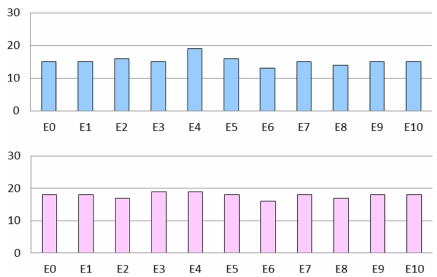
Figure 3. NRMSE of precipitation (%) for western river basin (top panel) and eastern river basin (bottom panel) automatic weather sta- tions.